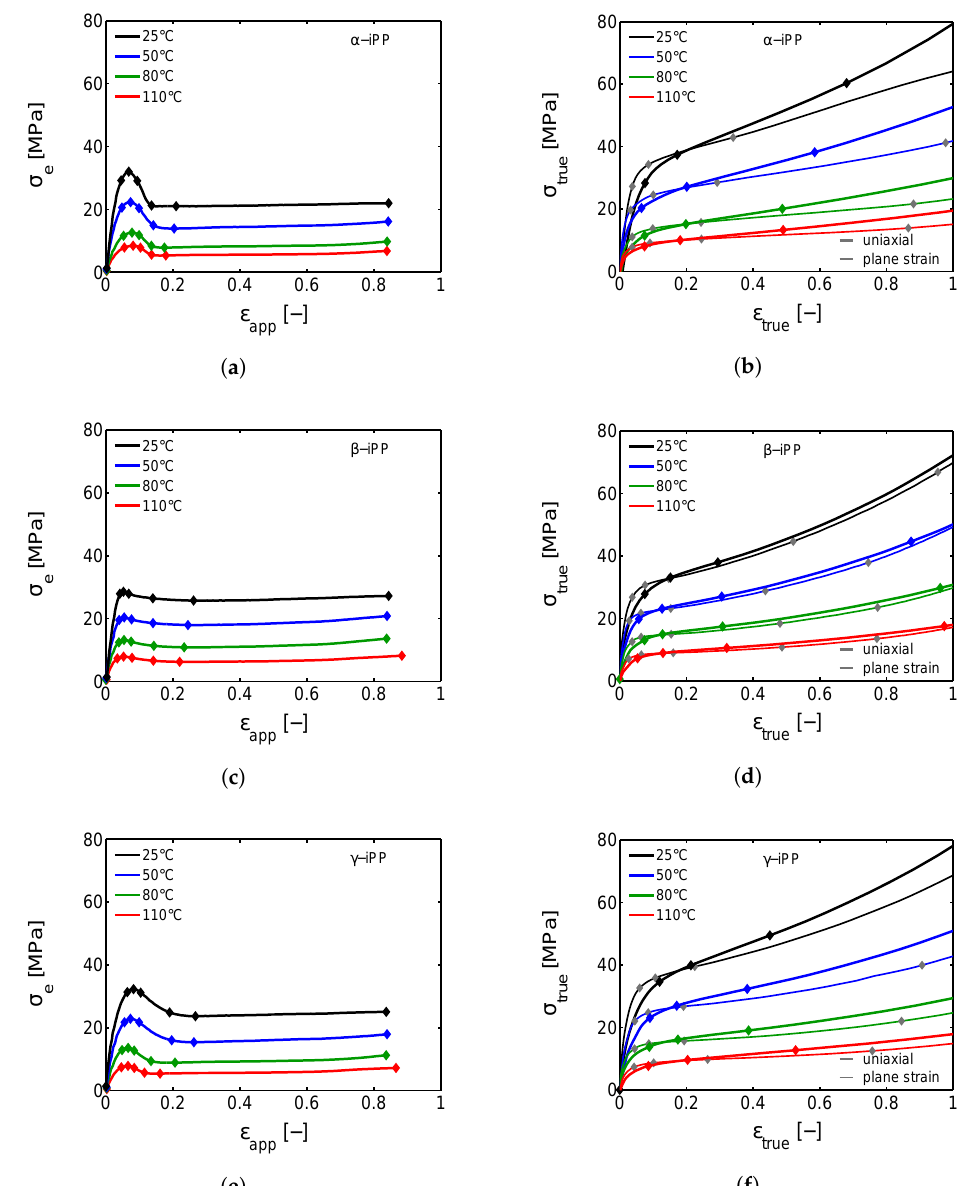
Figure 8. ( a , c , e ) The engineering stress as a function of the apparent strain for α -, β - and γ -iPP tensile experiments respectively, stretched at different temperatures and a rate of 12 µm/s; ( b , d , f ) The true stress as a function of true strain, corresponding to figure ( a , c , e ). The thick solid lines are calculated for the assumption of uni-axial deformation and the thin lines for plane strain. The markers in the figures correspond to the 2D WAXD and SAXS images, shown in the following